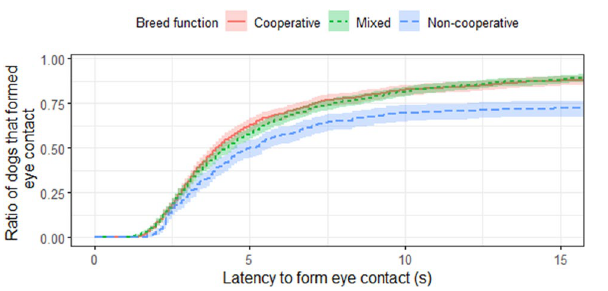
Figure 4. Survival plot for 125 pet dogs in the three breed function groups. E.g. after 15 s elapsed, usually ~ 90% of cooperative breeds and mixed breed dogs have already formed eye contact with the experimenter, while at the same time only ~ 75% of non-cooperative breeds